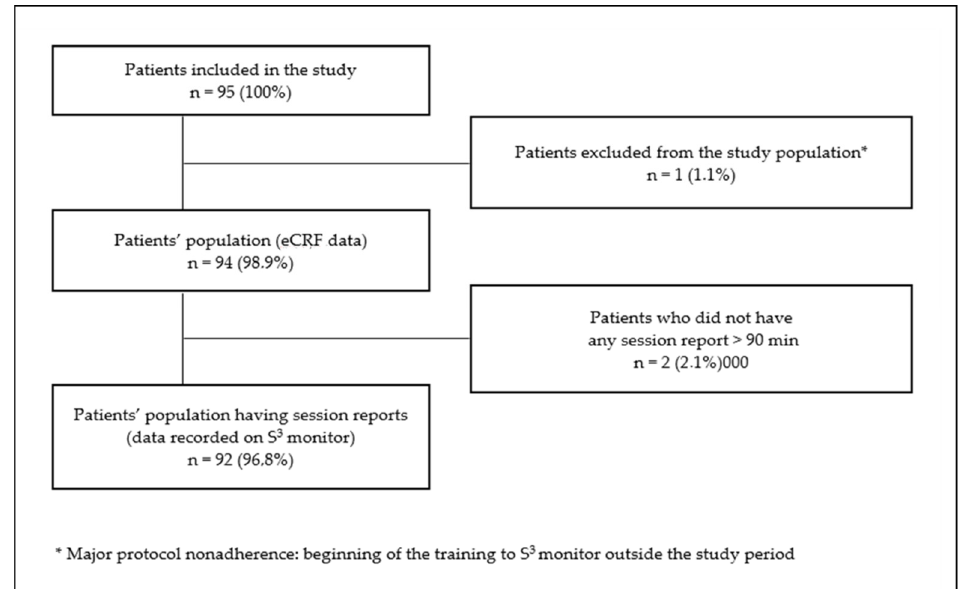
Figure 1. Flowchart of the study population.